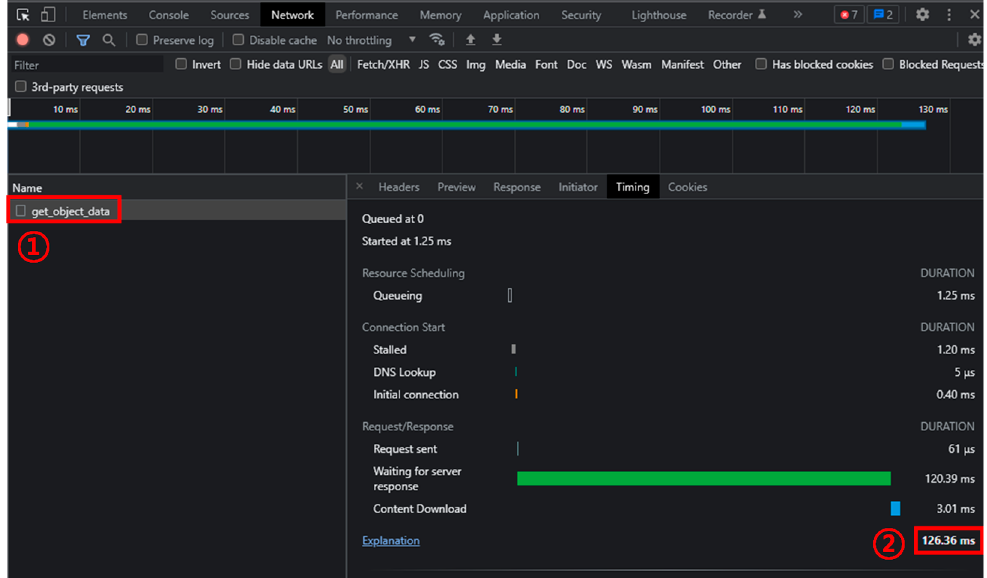
Figure 13. Measuring Inquiry (simple) Response Time in Browser Developer Tools Network Tab.